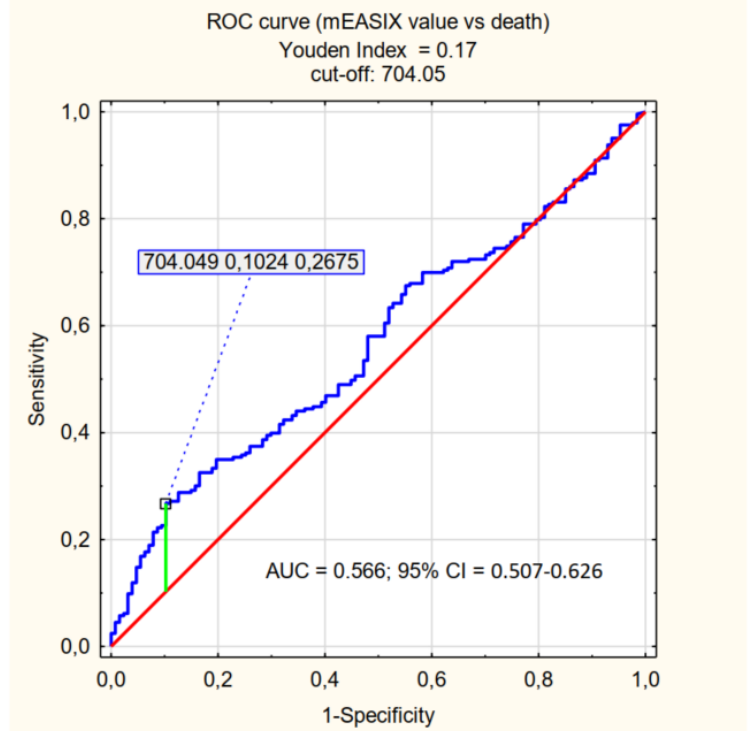
Figure 2. ROC curve (effect of mEASIX value on death) = mEASIX cut-off.